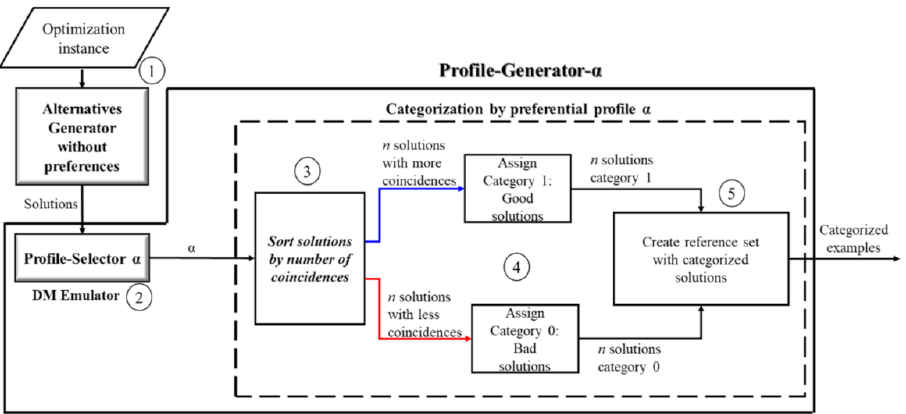
Figure 2. Profile-generator- α : the profiling method to imitate a decision maker in categorizing solutions.